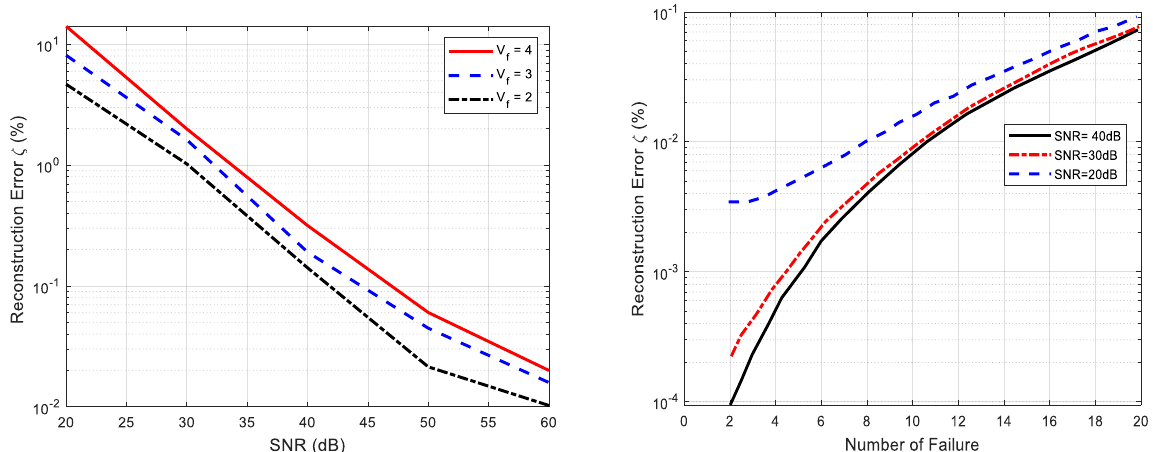
FIGURE 4. Reconstruction error versus SNR for different number of failure. FIGURE 5. Reconstruction error versus number of failure for different SNR.